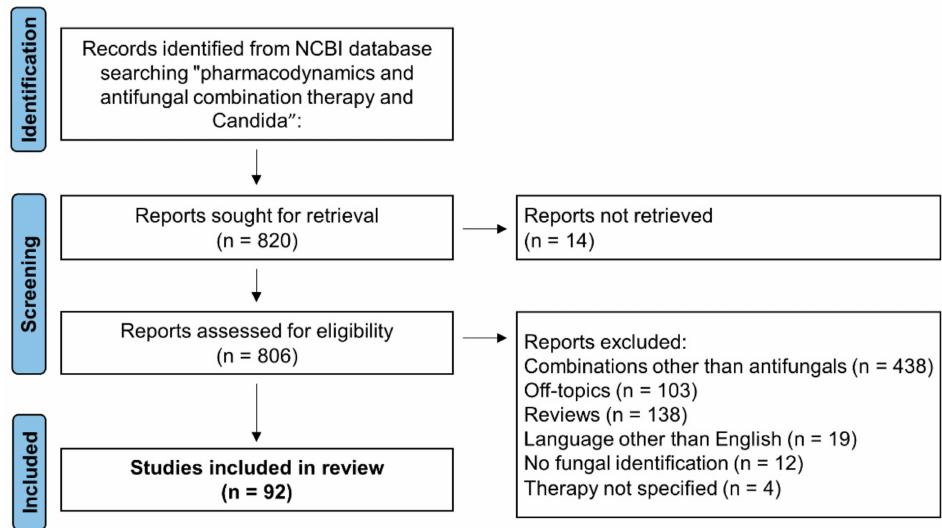
Figure 1. Flowchart of article selection process of this